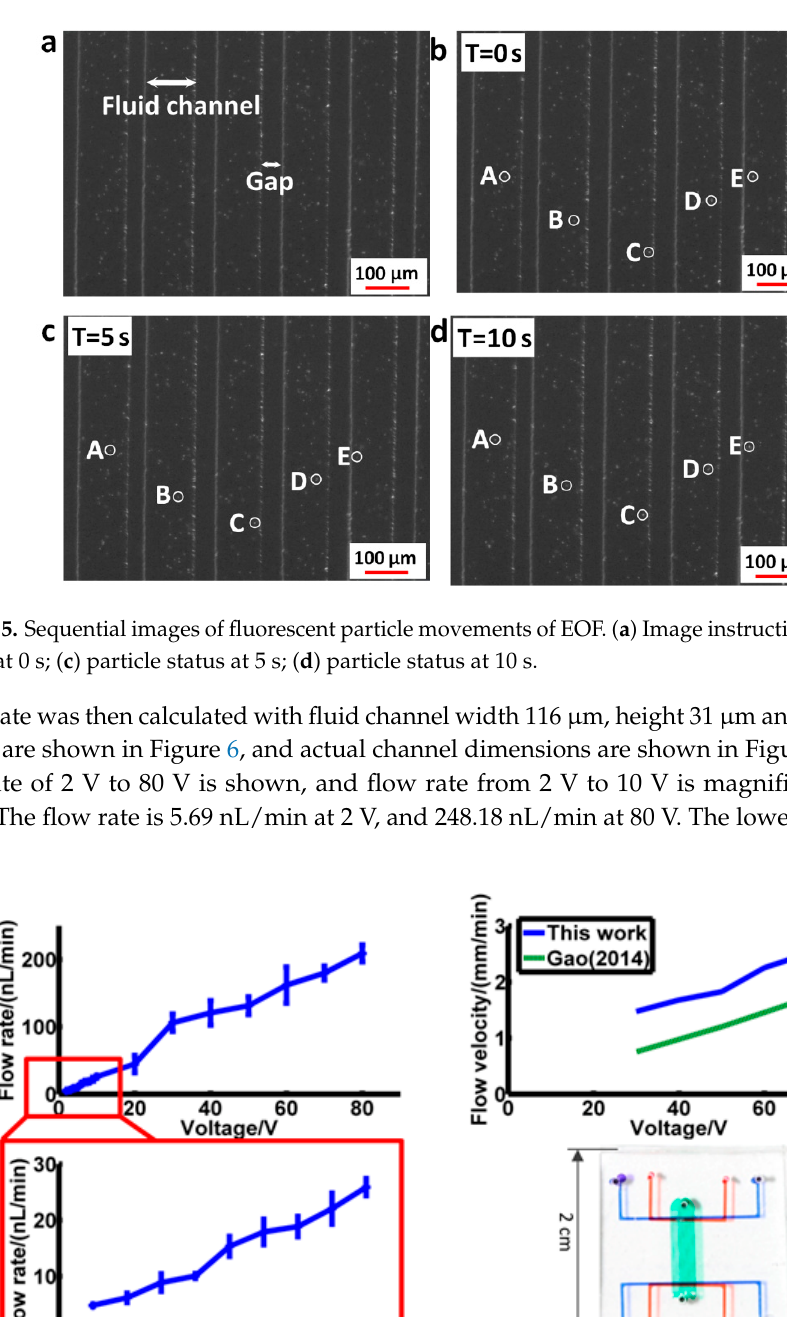
Figure 6. Flow rate at different voltage. ( a ) flow rate from 2 V to 80 V; ( b ) flow rate from 2 V to 10 V; ( c ) comparison of this work with Gao’s work [1] with similar dimensions; ( d ) size of this pump.